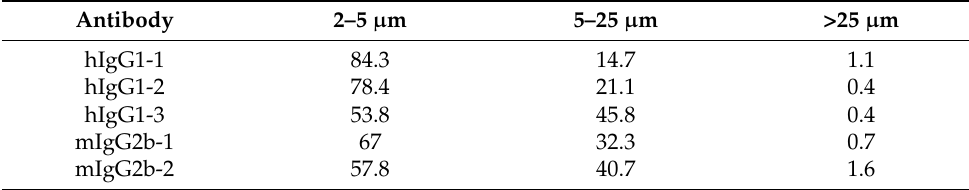
Table 1. Particle size distribution (%) of nebulized